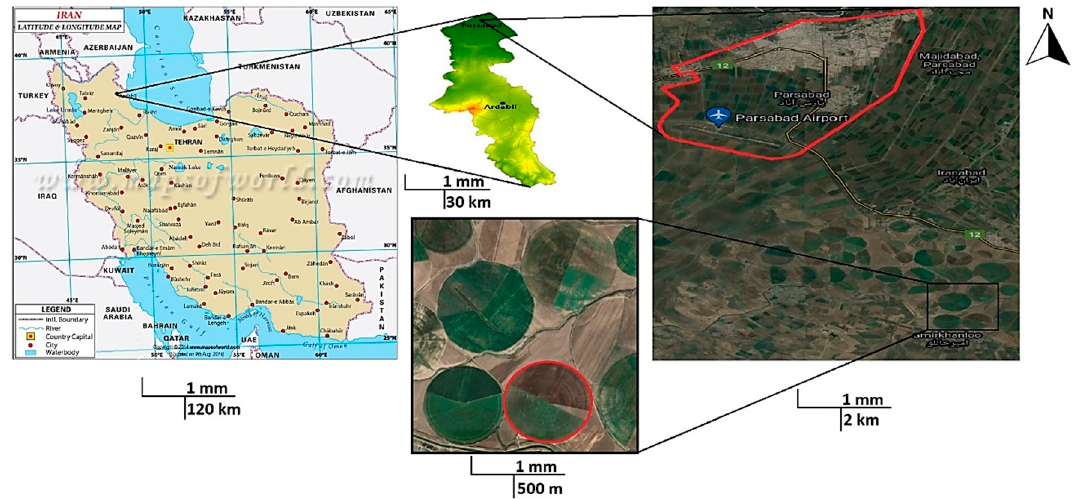
Figure 1. Location of oilseed rape host lands for Tetrax tetrax birds, MAIL Co, Ardabil, Iran.